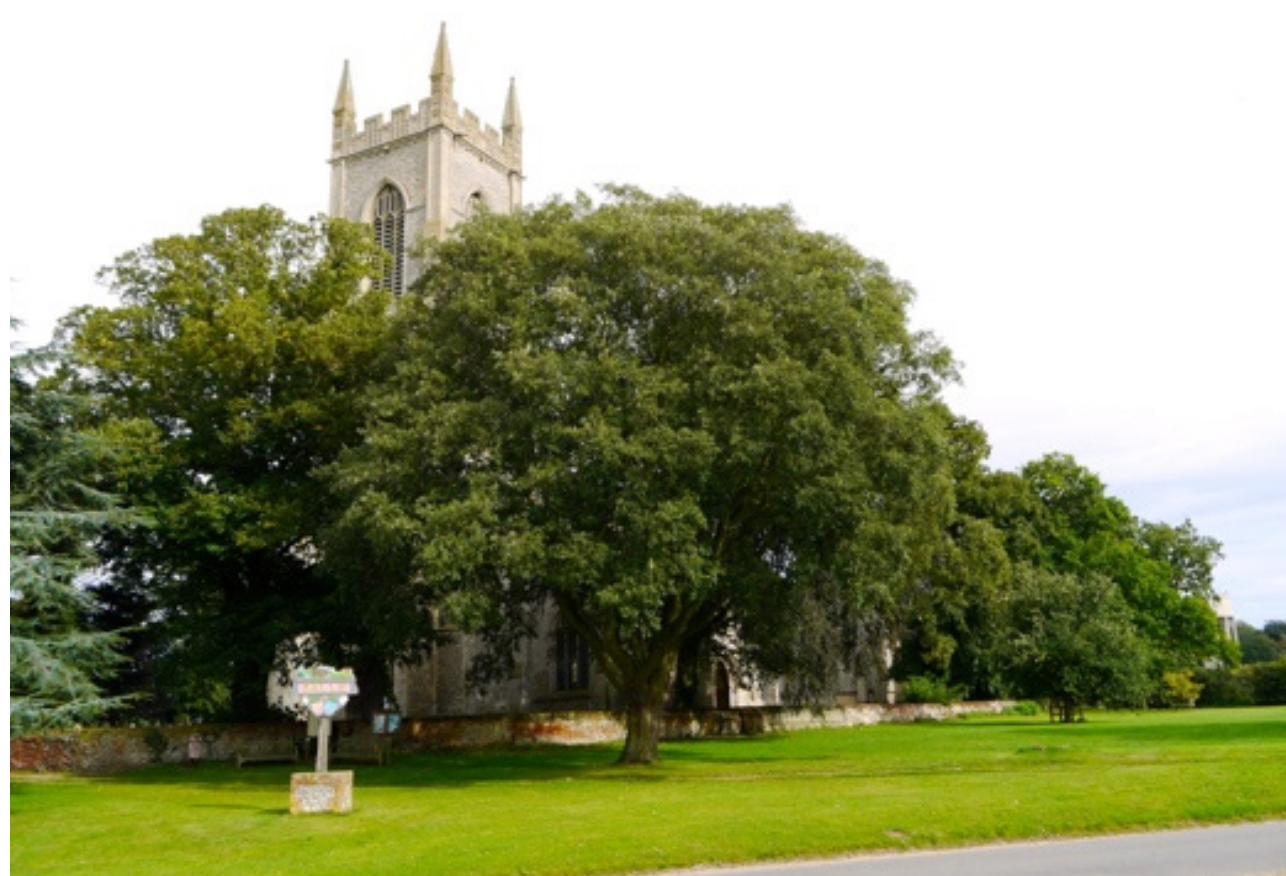
Figure 2. The church of St Peter and St Paul at Salle.